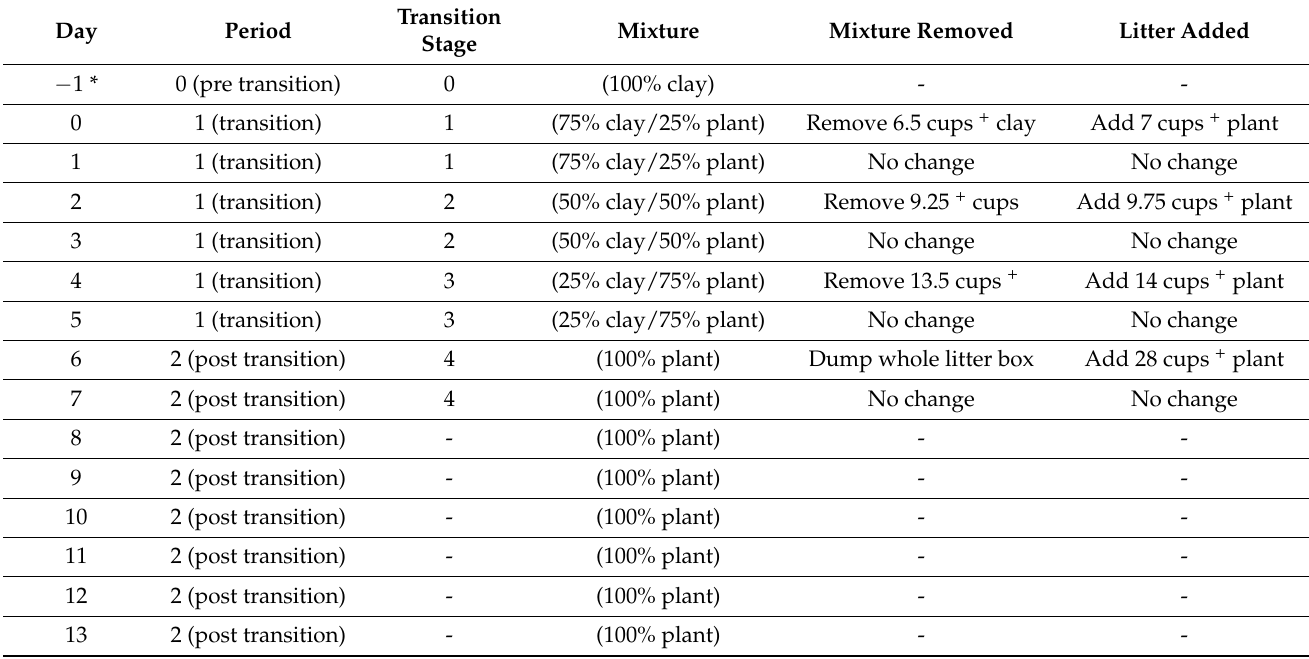
Table 1. Description of the study timeline including the litter box transition period (period 1) and the associated litter box transition calculations for litter boxes 1, 3, 5, and 7 based on